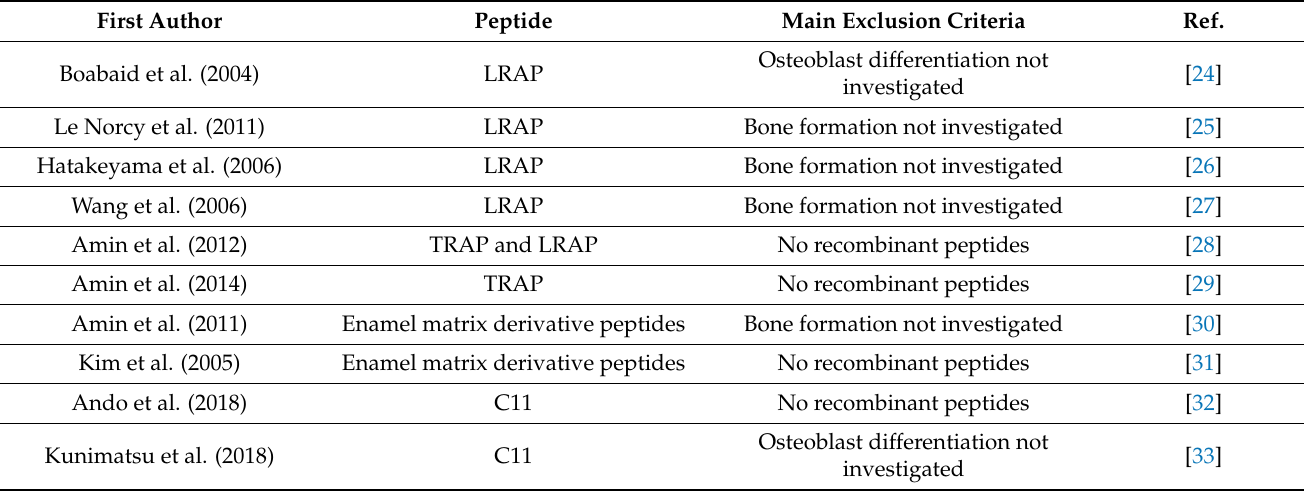
Figure 1. PRISMA flow chart and search strategy. Table 1. Articles excluded from the systematic review. The table reports the main reason for the